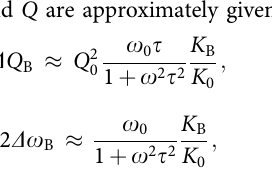
and non-equilibrium conditions,